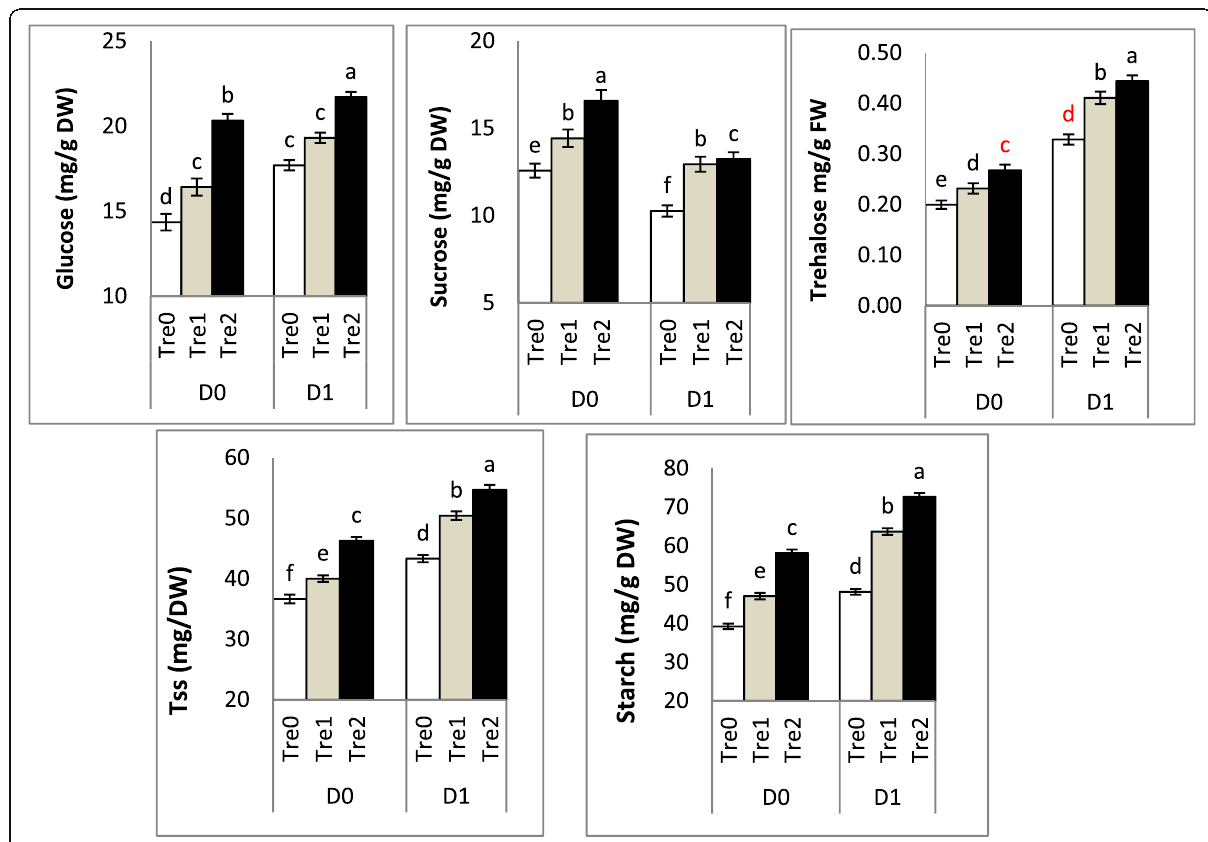
Fig. 1 Effect of trehalose (Tre1, 0.1 mM and Tre2, 0.5 mM) on carbohydrates constituents (TSS, glucose, sucrose, starch mg/g DW and trehalose μ g/g FW) of quinoa plant under drought stress (at 75 days from sowing). Each value represents the mean ± standard error ( n = 3). Means with different letters above bars were significantly different at the 0.05 level according to Duncan ’ s multiple range